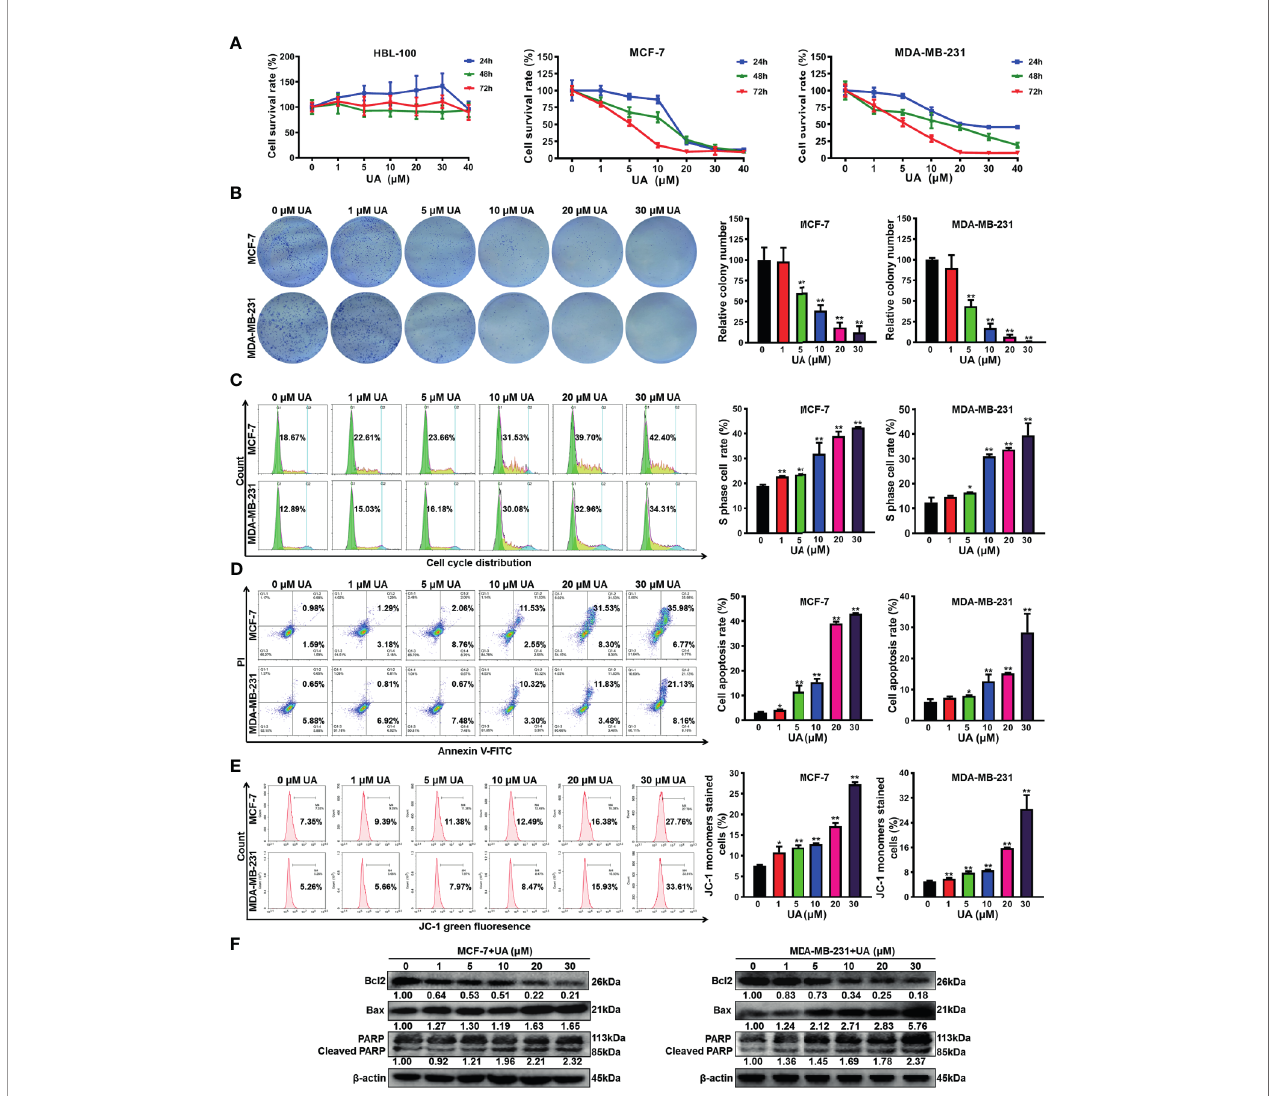
FIGURE 2 | Ursolic acid signi fi cantly restrains the proliferation and induces mitochondrial-mediated apoptosis of breast cancer cells in vitro . (A) HBL-100, MCF-7 and MDA-MB-231 cells were treated with 1~40 m M ursolic acid for 24~72 h The cytotoxicity of ursolic acid in different cell lines was detected by CCK8 assay. (B) Colony formation assay was conducted to investigate the effect of ursolic acid (1~30 m M) on the clonogenic activity of breast cancer cells following a 10-day culture period. (C) The cell cycle distributions of MCF-7 and MDA-MB-231 cells after ursolic acid (1~30 m M) treatment for 48 h were detected by fl ow cytometry. (D) The apoptosis ratios of MCF-7 and MDA-MB-231 cells after ursolic acid (1~30 m M) treatment for 48 h were detected by Annexin V-FITC/PI staining and fl ow cytometry. (E) The mitochondrial depolarization and apoptosis of MCF-7 and MDA-MB-231 cells after ursolic acid (1~30 m M) treatment for 48 h were detected by JC-1 staining assay and fl ow cytometry. (F) The expression changes of the indicated proteins in MCF-7 and MDA-MB-231 cells after ursolic acid (1~30 m M) treatment for 48 h N = 3. * p < 0.05. ** p <